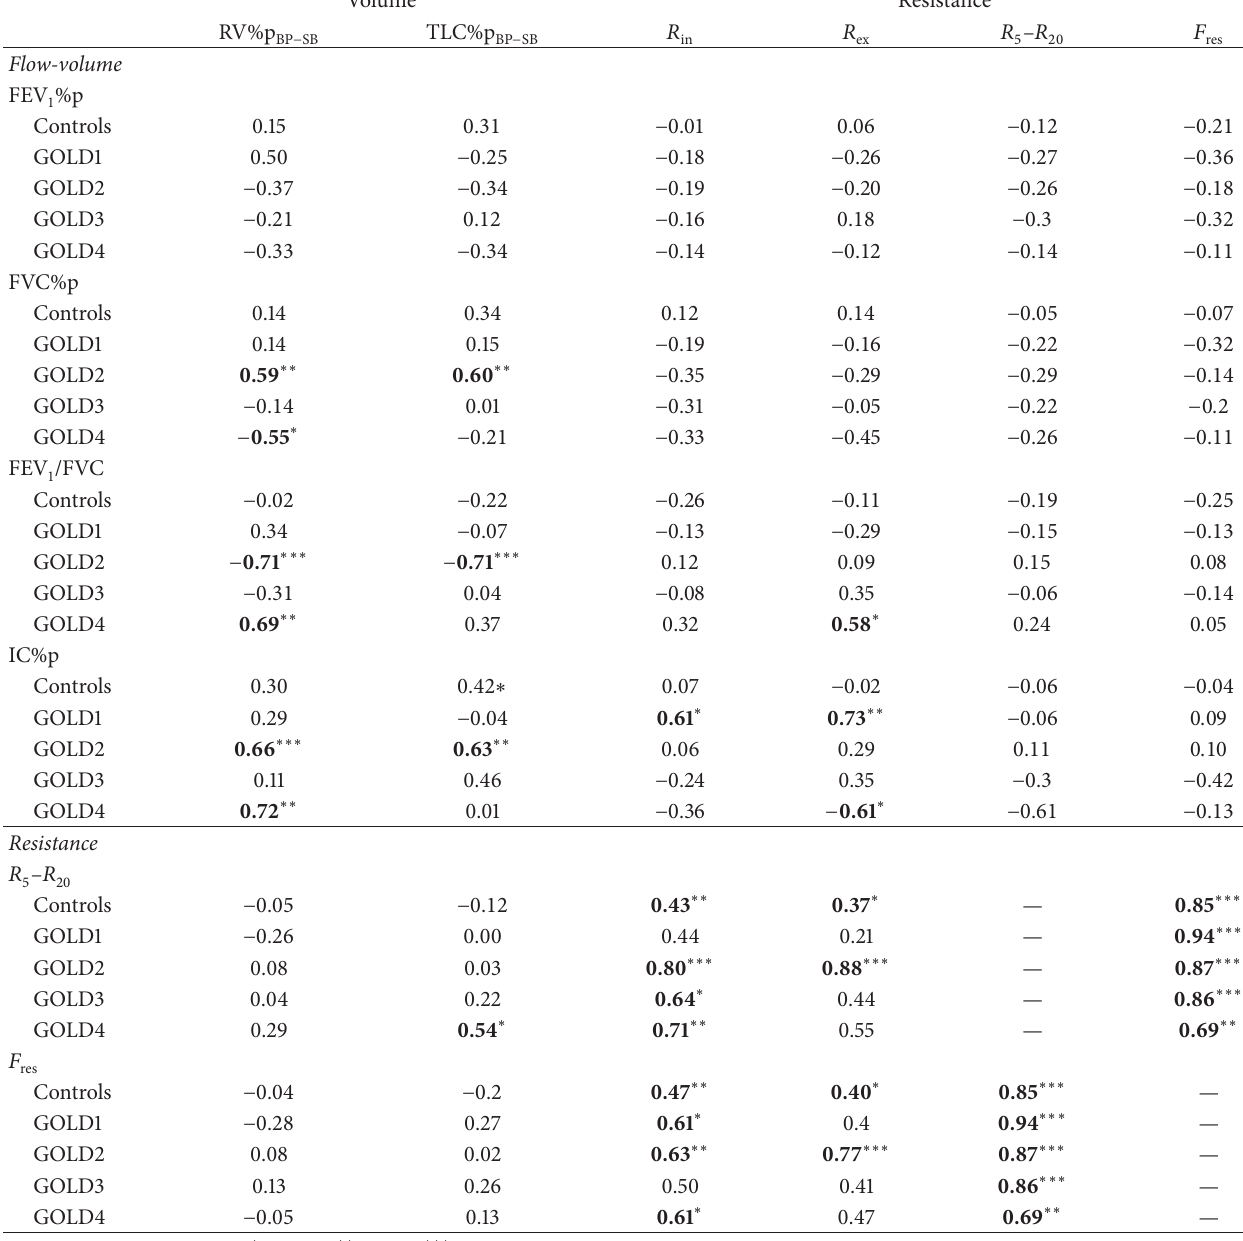
Table 4: Correlations between established flow-volume parameters and extended volume and resistance parameters.